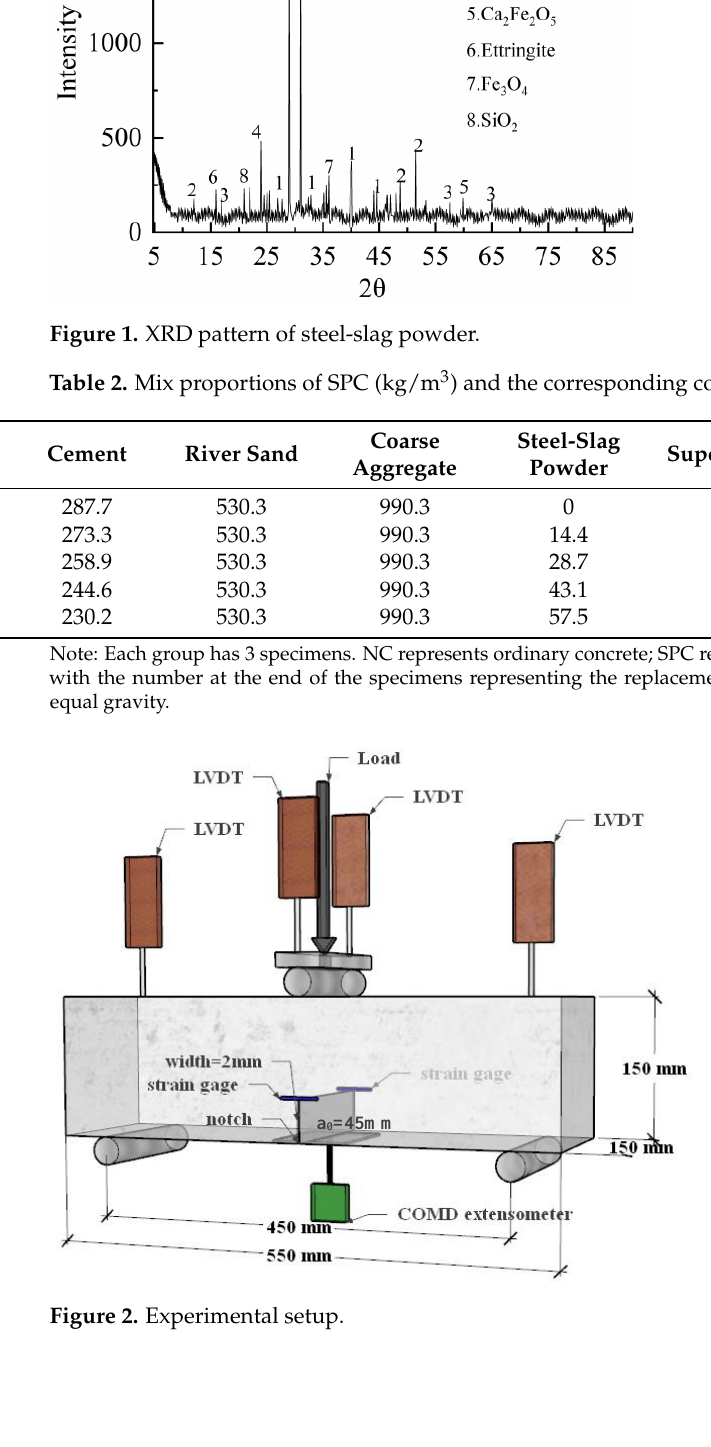
Figure 2. Experimental setup.